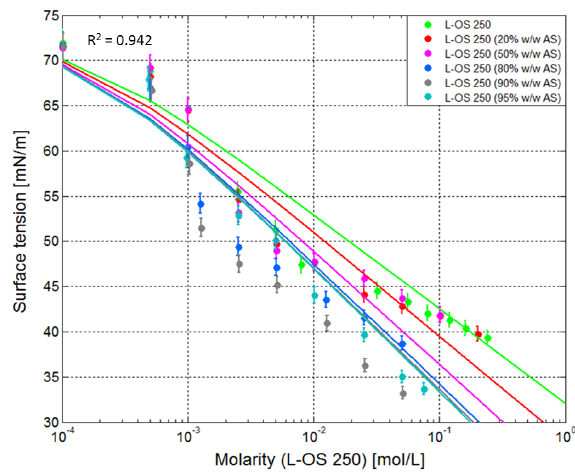
Figure 3. Surface tension as a function of the concentration of limonene organosulfate (L-OS 250) for six mixtures of L-OS 250 and ammonium sulfate (AS). Note that the data are plotted in semi- log space. Lines represent parametrisation curves and error bars show the 2% instrumental